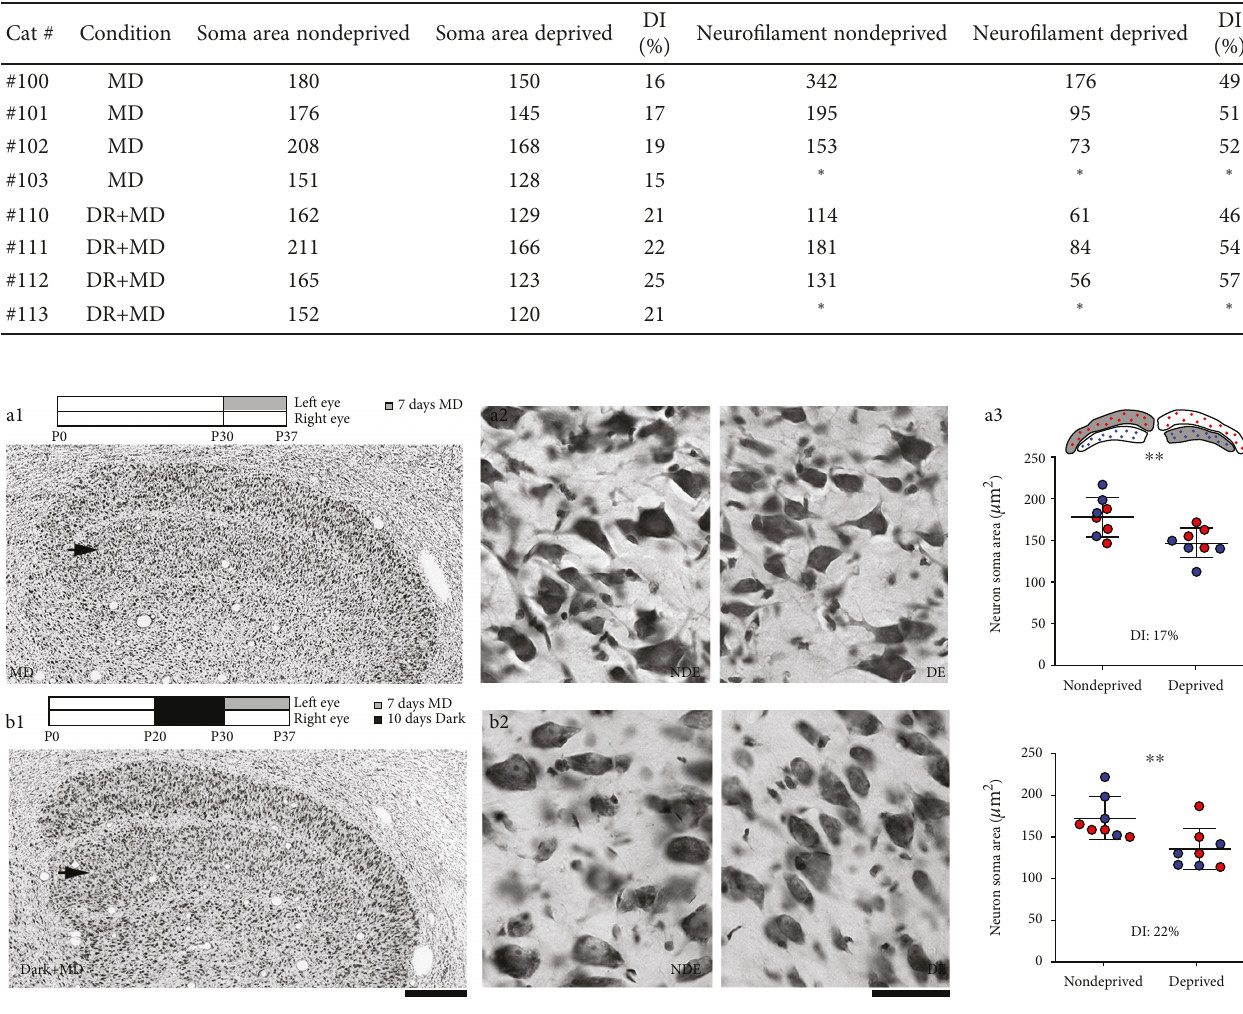
Figure 2: The e ff ect on neuron size of a 7-day duration of MD imposed at the peak of the critical period with and without a prior 10-day period of darkness. Schematic at the top of (a1) and (b1) indicate the rearing history and timeline of procedures for each group. The e ff ect of 7 days of MD imposed at postnatal day 30 was obvious upon gross examination of the eye-speci fi c layers of the dLGN (a1), as well as at higher magni fi cation where neurons within deprived-eye (DE) layers were smaller than neurons within non-deprived-eye (NDE) counterpart layers. Stereological quanti fi cation of soma size revealed that deprived neurons were rendered 17% smaller than nondeprived neurons, which represented a signi fi cant di ff erence. When the same MD was imposed immediately following 10 continuous days of dark exposure started at postnatal day 20, there was an obvious reduction in the staining intensity within deprived-eye layers compared to non- deprived-eye layers (b1). The paler staining within deprived-eye layers was accompanied by a reduction in the size of deprived neurons when compared to nondeprived neurons (b2). Quanti fi cation of neuron cross-sectional soma size revealed that deprived neurons were signi fi cantly smaller than nondeprived neurons by an average of 22%. Drawing in (a3) represents eye-speci fi c layers of the dLGN with red and blue circles indicating measurements from A and A1 layers, respectively. Scale bars = 500 μ m (1) and 50 μ m (2). Arrows in (a1) and (b1) indicate the deprived-eye layer. Asterisks indicate statistical signi fi cance at probability < 0 05